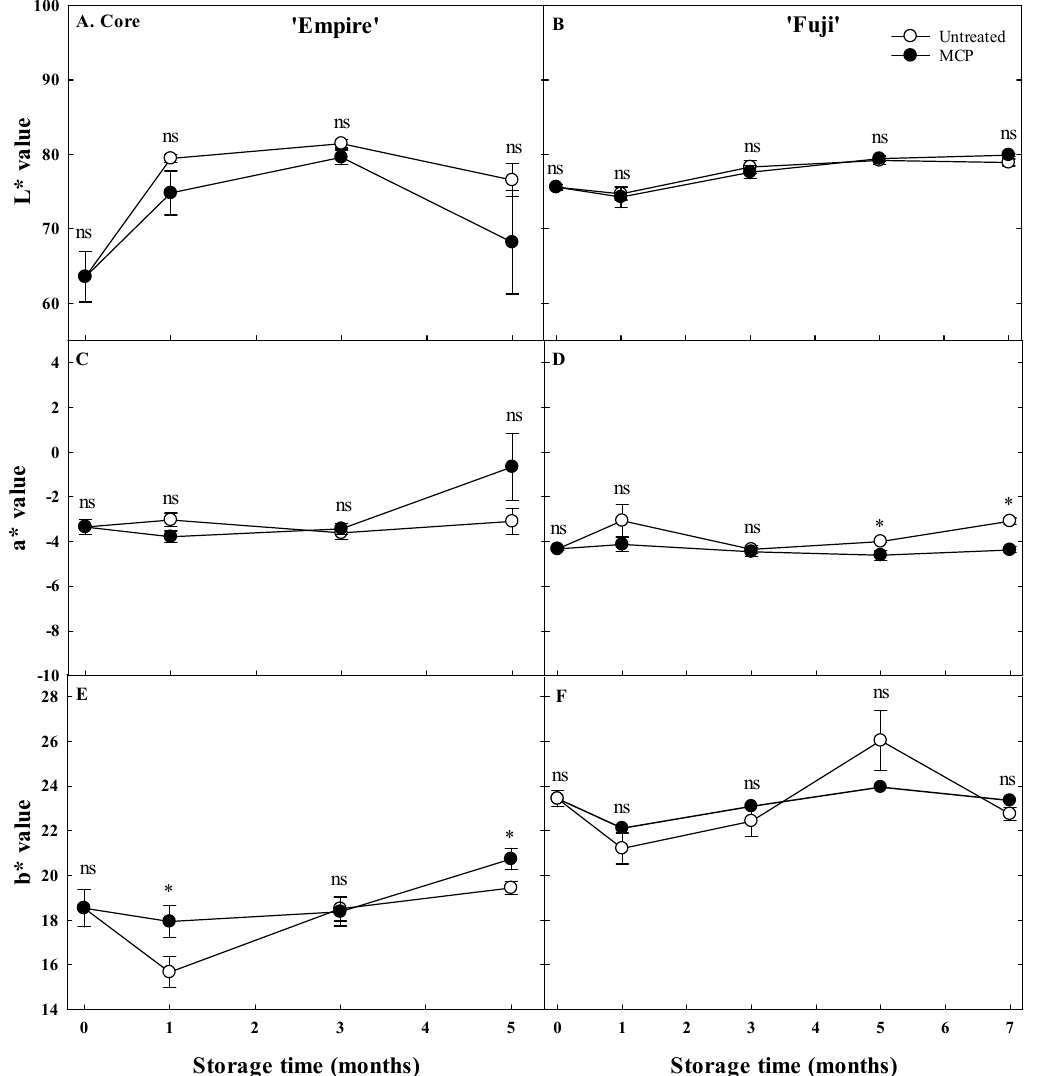
Figure 7. Color L* ( A , B ), a* ( C , D ), and b* values ( E , F ) of core tissue on ‘Empire’ and ‘Fuji’ apples, either untreated or treated with 1 µL·L − 1 1-MCP, and stored at 0.5 °C in air storage for up to five and seven months, respectively. Bars represent error of the means (S.E.M; n = 5) when larger than the dimension of the symbol. ns and * indicate non-significant and significant differences between untreated and 1-MCP treatments at p < 0.05, respectively.